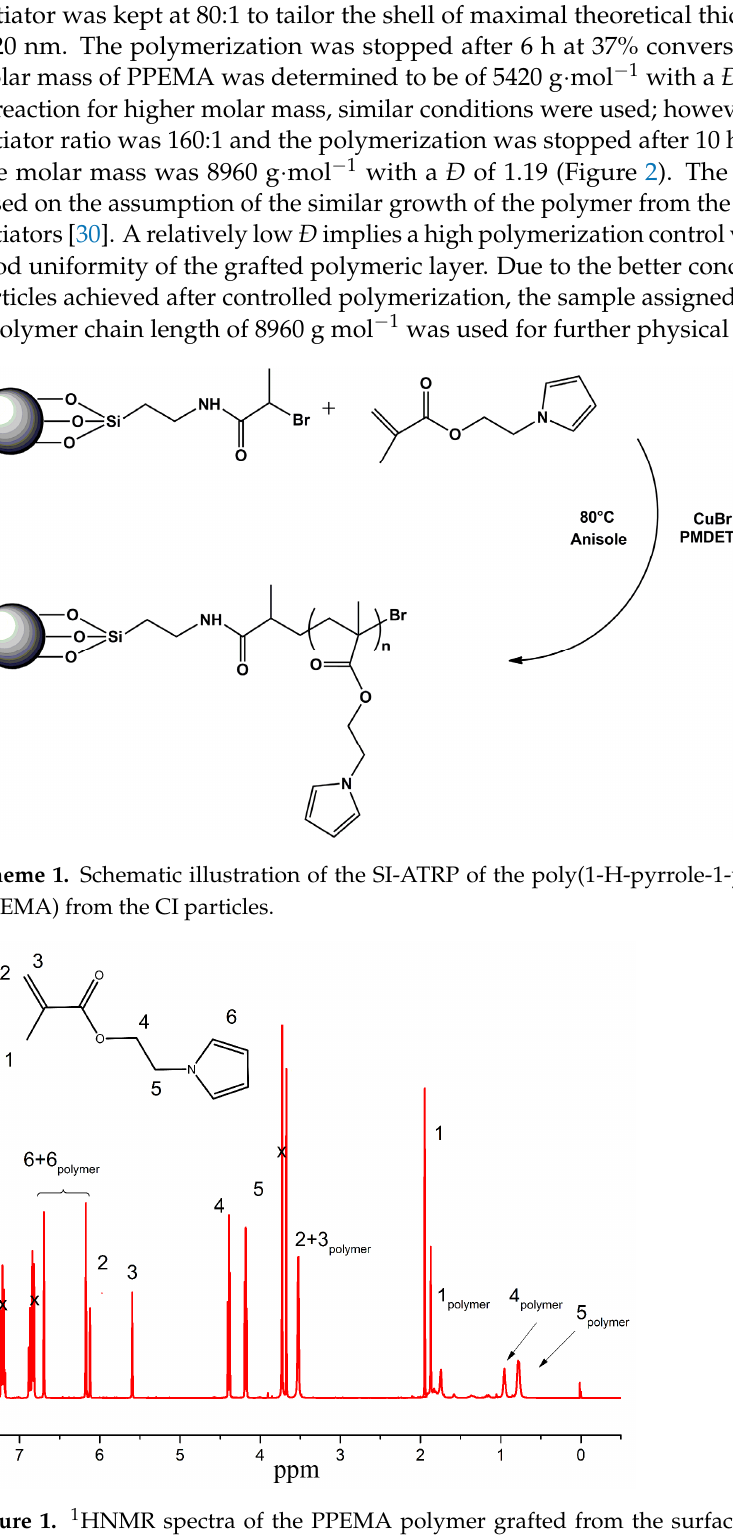
Figure 2. GPC analysis of the CI ‐ PPEMA of various molecular weights ( a ) for 5420 g mol − 1 and ( b ) for 8960 g mol − 1 . The presence of the grafted polymer on the surface of CI was confirmed by FTIR (Figure 3). As can be seen in Figure 3a, the typical C ‐ H absorption bands are visible at 2993 cm − 1 and 2841 cm − 1 . Furthermore, presence of carbonyl from methacrylate is visible for C=O stretching vibration at 1724 cm − 1 . Successful synthesis of PPEMA is also con ‐ firmed by peak at 1550 cm − 1 as new absorption band of C ‐ N. C ‐ H vibrations are present at 1020 cm − 1 . The oxidized form of the PPy moiety is clearly seen at 951 cm − 1 , which is typical for certain doping state [31]. In case of CI ‐ PPEMA composite particles, the most visible peaks corresponding to the carbonyl 1724 cm − 1 , to the C ‐ H at 1050 cm − 1 and final ‐ ly to the oxidized form of PPy moiety present on the surface of the particles.